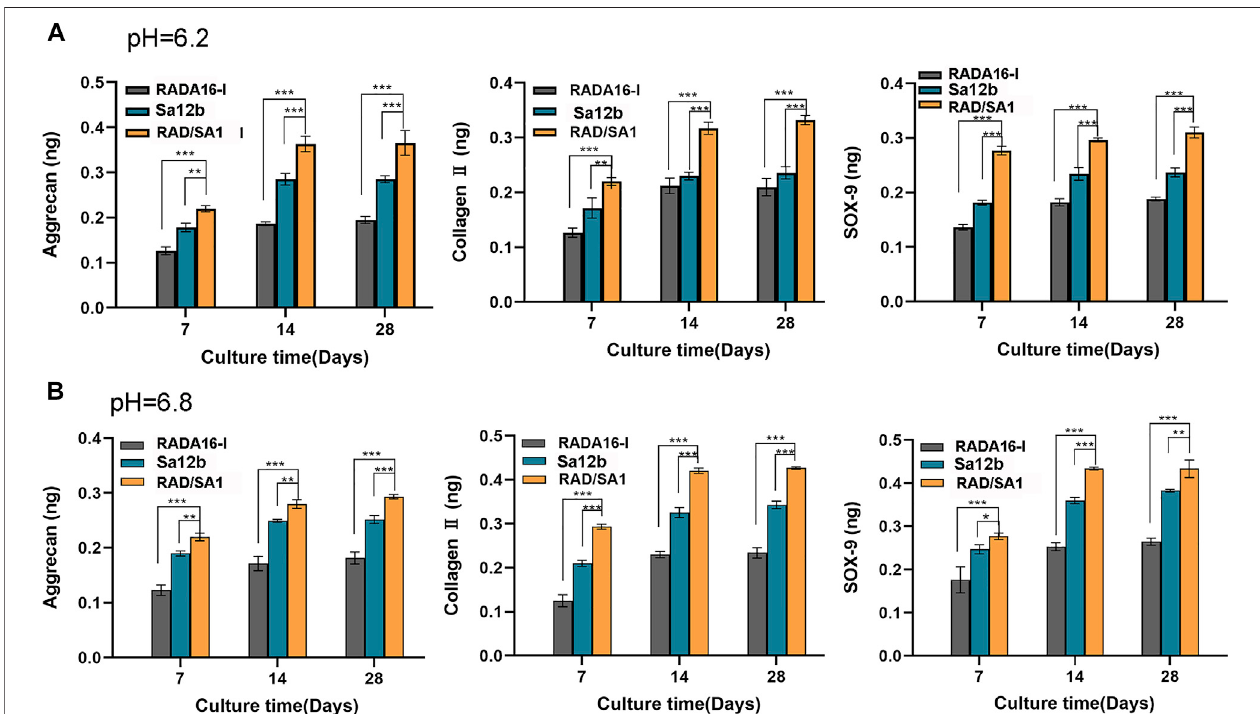
FIGURE6| ELISArevealedthatthe amounts ofcollagenII, aggrecan and SOX-9 secreted byhNPMSCs were signi fi cantlydifferentamong thethree groups(RAD/ SA1, Sa12b and RADA16-I) after 7, 14 and 28 days, respectively. (A) hNPMSCs were cultured at pH 6.2. (B) hNPMSCs were cultured at pH 6.8. When the two groups compared, ** indicates p < 0.01, and *** indicates p < 0.001.